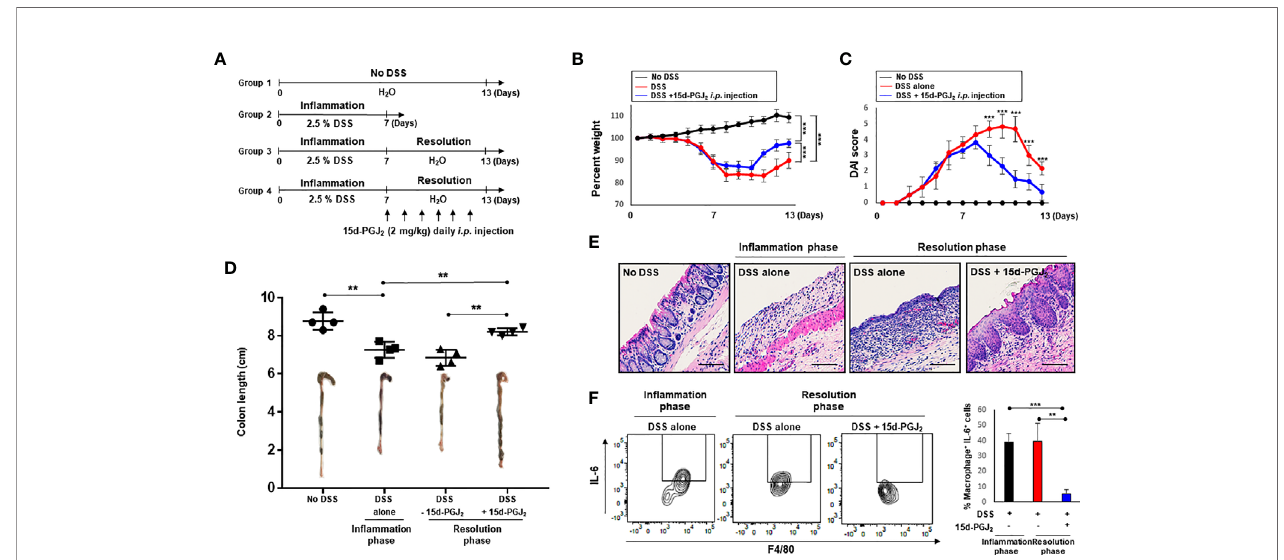
FIGURE 5 | 15d-PGJ 2 treatment administration accelerates the resolution of colitis and inhibits IL-6 expression in intestinal macrophages of DSS-treated mice. (A) Mice were administrated with drinking water containing 2.5% DSS for 7 days, followed by normal water for 6 days during which 15d-PGJ 2 (2 mg/kg) or vehicle was intraperitoneally injected on daily basis. Gradual change of body weight (B) and DAI. (C) were measured every day during the experiment period. (D) The comparison of the colon length at the in fl ammation phase and resolution phase of intestinal in fl ammation. (E) Representative distal colon sections stained with H&E. Scale bar, 200 m m. (F) Intestinal macrophages were collected on day 7 or day 13 from DSS-treated mice, and the proportion of macrophages expressing IL-6 (CD45 + CD11b + Gr-1 − F4/80 + IL-6 + ) was measured by fl ow cytometry. *, **, *** Signi fi cantly different between the groups compared (* p < 0.05, ** p < 0.01, and *** p <